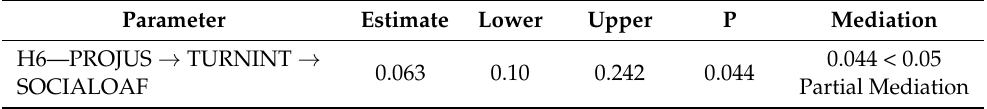
Table 5. Mediation type (developed by the